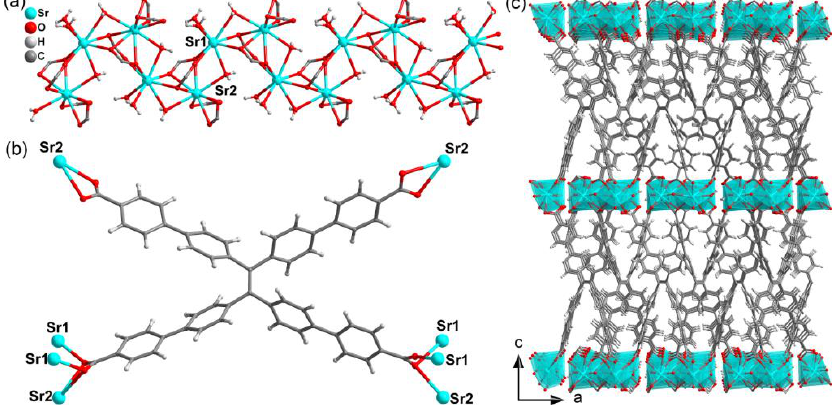
Figure 1. ( a ) The coordination environments of Sr 2+ ions in the 1D chain-like SBU of structure Sr 2 (tcbpe). ( b ) The coordination mode of tcbpe 4 − in Sr 2 (tcbpe). ( c ) The 3D skeleton of Sr 2 (tcbpe) seen from the b -axis.